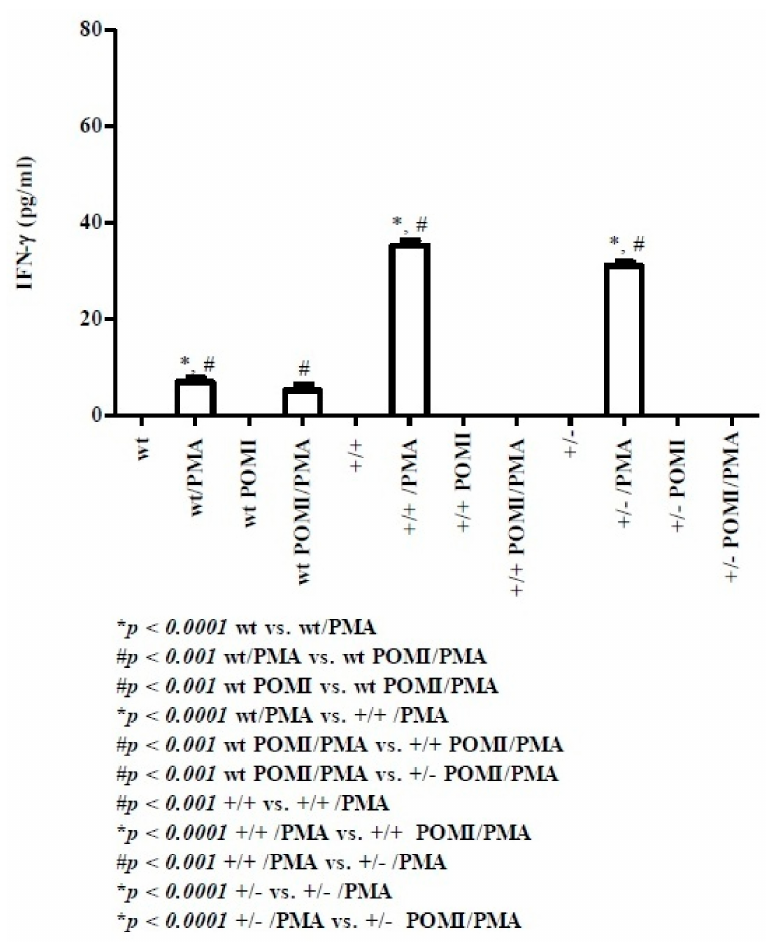
Figure 3. Levels of IFN- γ in splenic supernatants from cell cultures of mice at day 30. For methods, abbreviations, and statistical analysis, see Figures 1 and